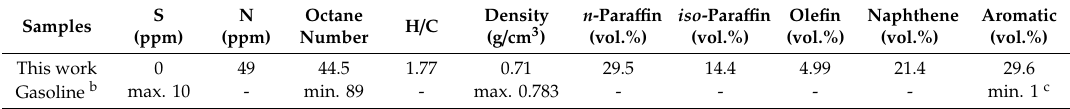
Table 1. The elemental analysis, composition and octane number of gasoline-like fuel a .